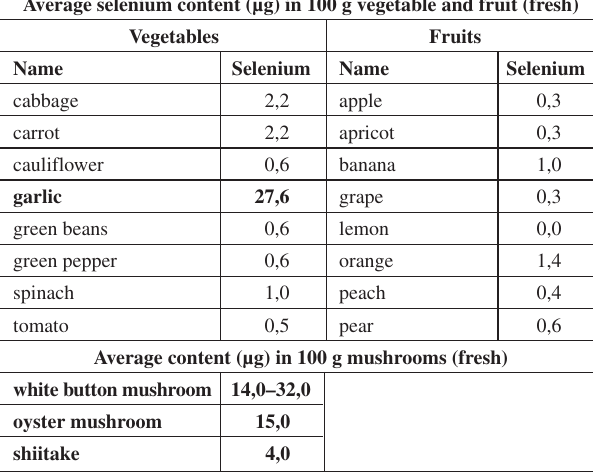
Table 4. Average selenium content (µg) in 100 g vegetables, fruits and mushrooms (fresh) Average selenium content (µg) in 100 g vegetable and fruit (fresh) Vegetables